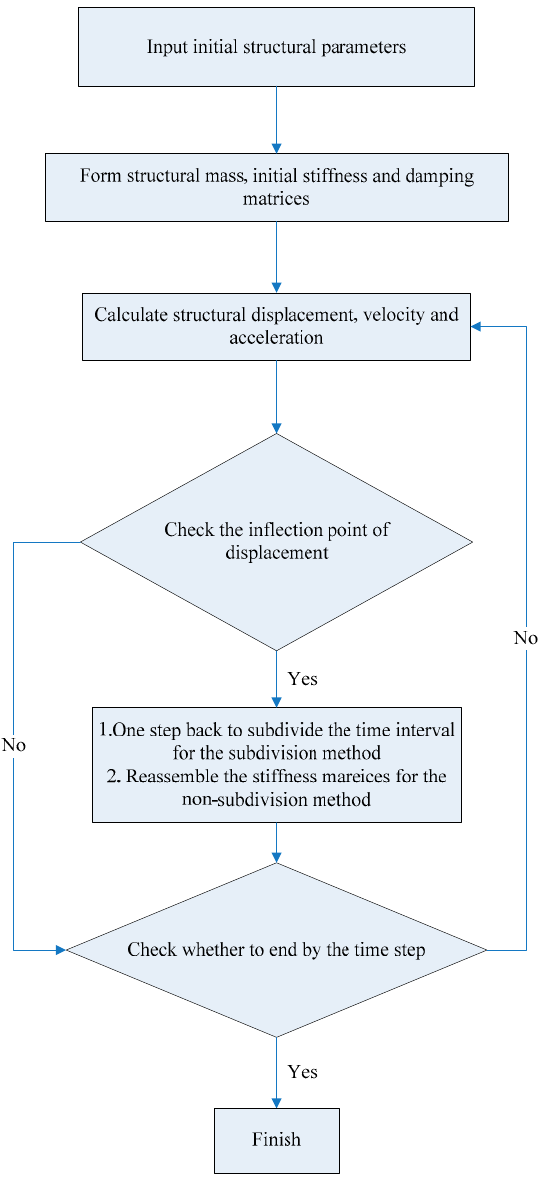
Figure 7. Numerical flowchart using the subdivided integral step and the full integral step.